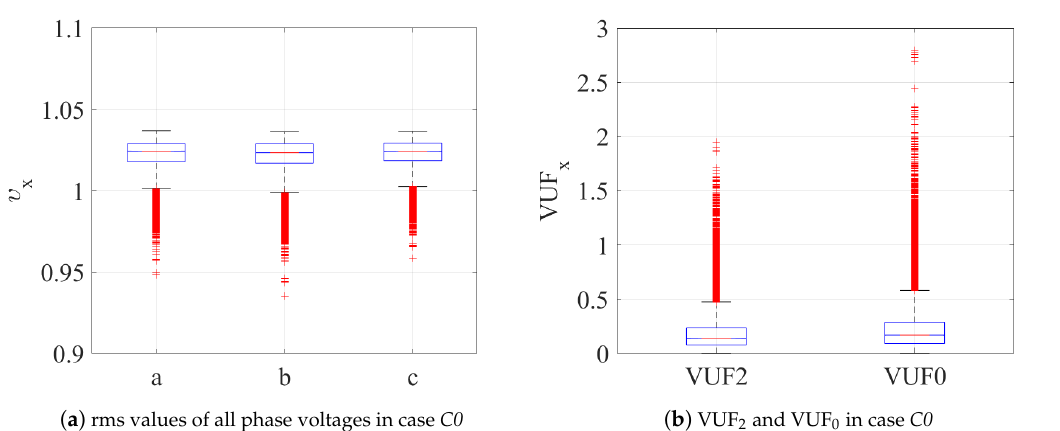
Figure 6. Concatenated results of the entire low-voltage (LV) grid when case C0 is